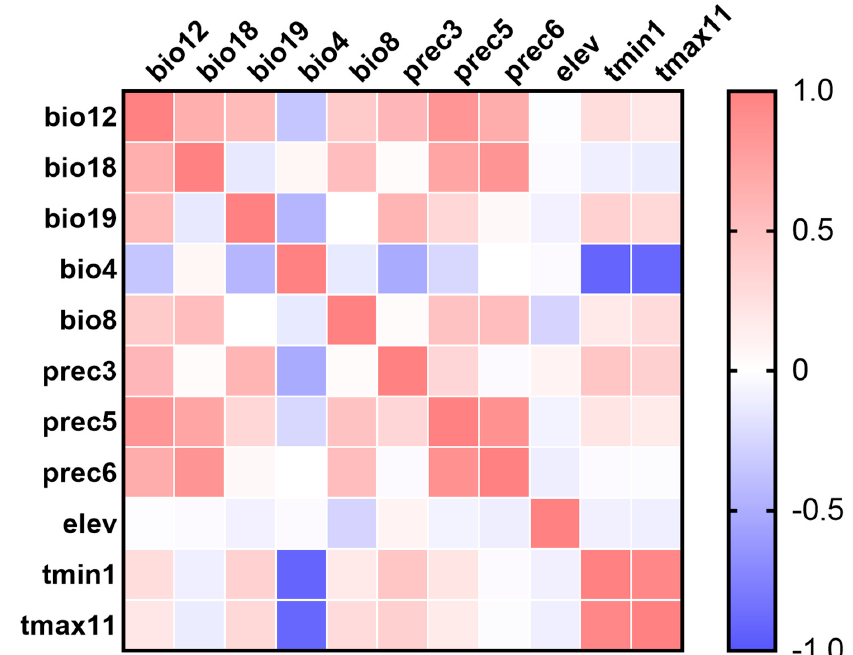
Figure 1. Pearson’s correlation matrix heatmap of environmental variables with contribution percentage greater than 1%. The variables include bio12 (annual precipitation), bio18 (precipitation of warmest quarter), bio19 (precipitation of coldest quarter), bio4 (temperature Seasonality (standard deviation × 100)), bio8 (mean temperature of wettest quarter), prec3 (precipitation of March), prec5 (precipitation of May), prec6 (precipitation of June), elev (elevation), tmin1 (minimum temperature of January), tmax11 (maximum temperature of November). Table 1. Percent contribution and permutation importance of the environmental variables in the MaxEnt model.